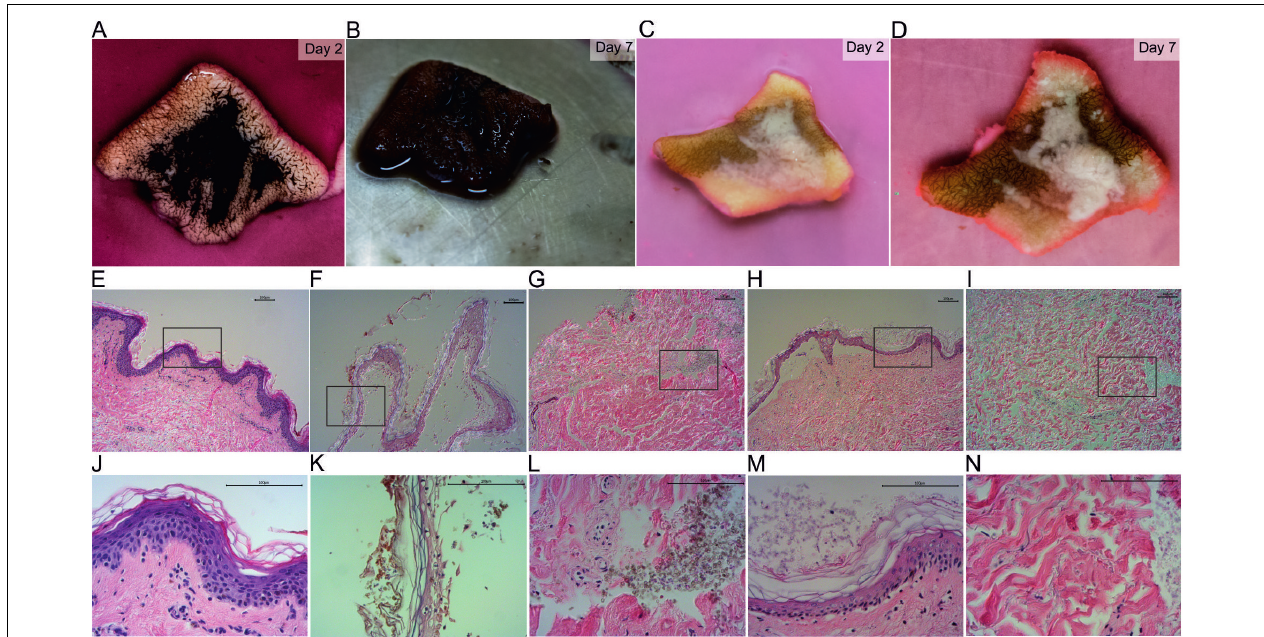
FIGURE 2 | HE stained sections of inoculated ex vivo skin explants. Ex vivo skin explants after 2 days (A,C) and 7 days (B,D) inoculated with the wild-type (A,B) and the mutant (C,D) at 37 ◦ C. The brown color in (C) and (D) derives from surgical ink used for incisional markings in plastic-reconstructive surgery and does not originate from the mutant fungus. HE stained sections of ex vivo skin explants without fungal inoculum (E,J) , the wild-type (F,G,K,L) and the mutant (H,I,M,N) . Epidermal samples of the wild-type (F,K) and the mutant (H,M) and dermal tissue of wild-type (G,L) and mutant (I,N) are shown. Areas marked with a black box (E–I) are shown in higher magnification in the lane below (J–N) . Scale bars: 100 µ